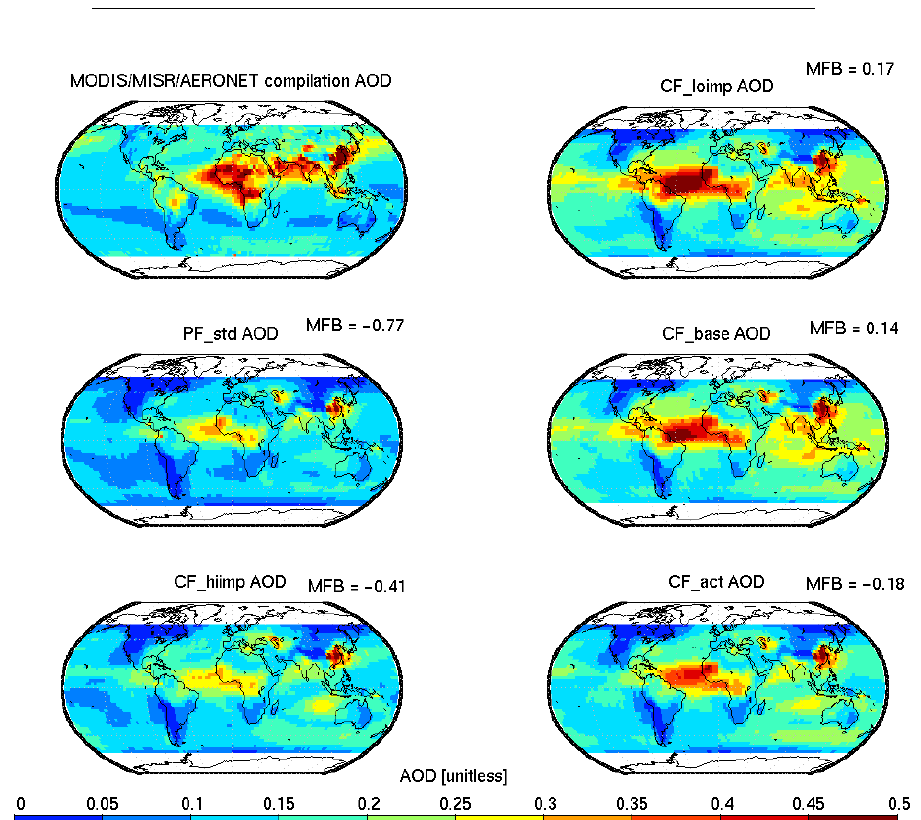
Fig. 2. The geographic distribution of annual mean aerosol optical depth (AOD) from the MODIS/MISR/AERONET compilation dataset of van Donkelaar et al. (2010) and for the simulations PF std, CF loimp, CF base, CF act, and CF hiimp. The mean fractional bias (MFB) (Boylan and Russell, 2006) between the simulated and retrieved AOD is shown to the upper right of each panel. The simulations are described in Table